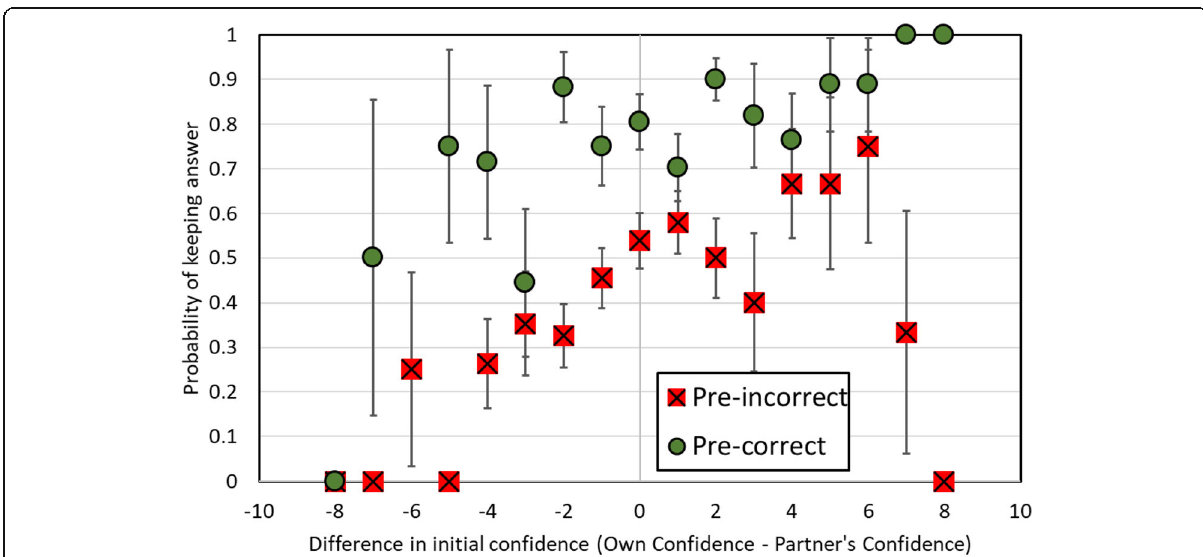
Fig. 3 The probability of keeping one ’ s answer in situations where one ’ s partner initially disagreed as a function of the difference between partners ’ levels of confidence. Error bars indicate the standard error of the proportion and are not shown when the data are based upon a single data point